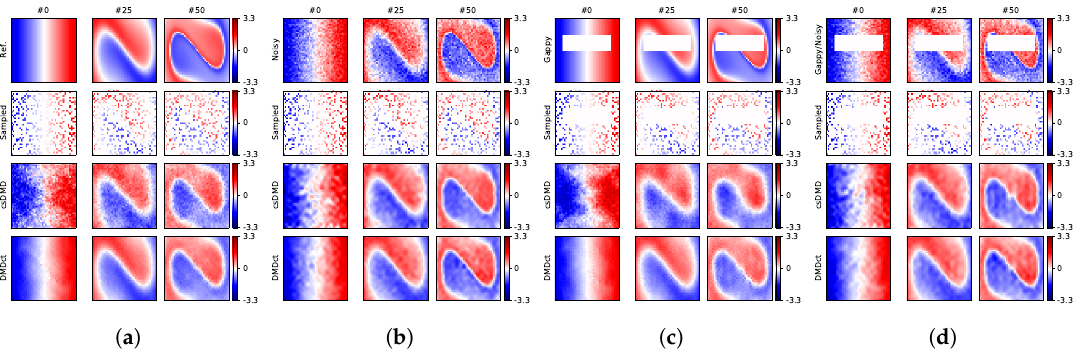
Figure 5. Results of Duffing dataset reconstruction using the first random sampling mask with both DMDct and csDMD. The snapshot numbers are shown at the top of each column. The error metrics are listed in Table 1. ( a ) The noise-free case without gap. ( b ) The noisy case without gap. ( c ) The noise-free case with the rectangular gap (the white hollow). ( d ) The noisy case with the rectangular gap (the white